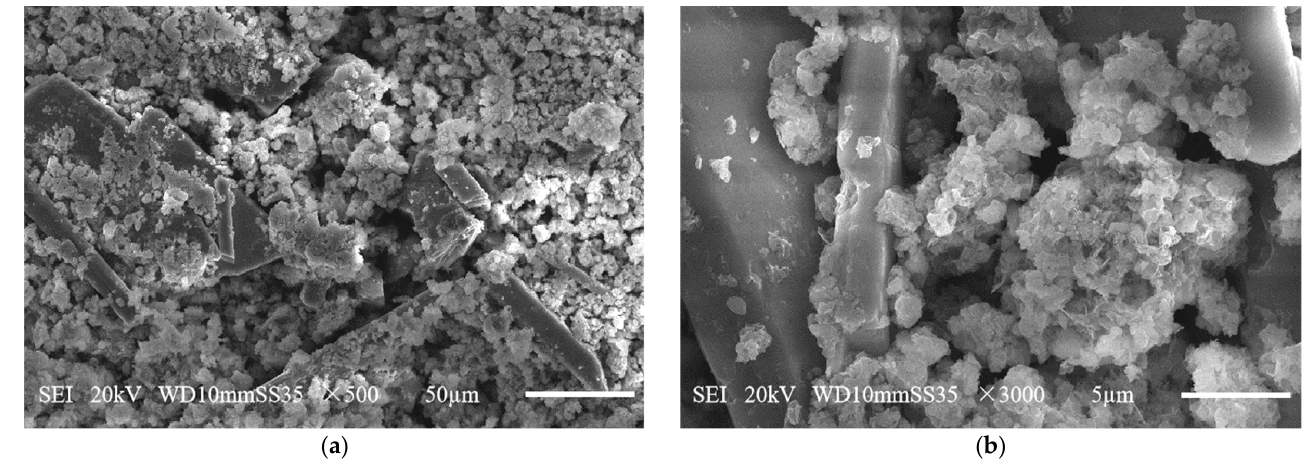
Figure 2. SEM micrographs of natural air-dried SR. ( a ) 500×; ( b ) 3000×.